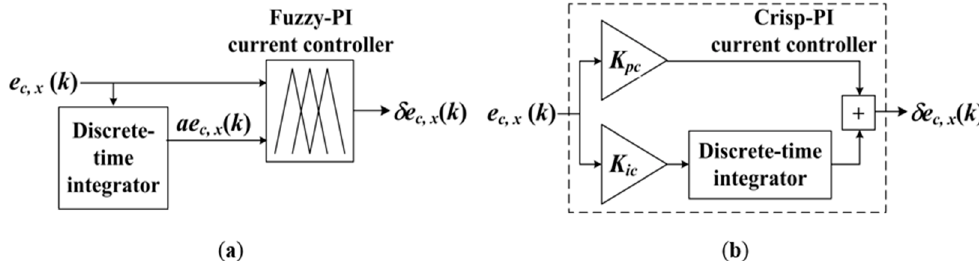
Figure 10. Block diagrams of ( a ) Fuzzy ‐ PI and ( b ) Crisp ‐ PI current controllers.